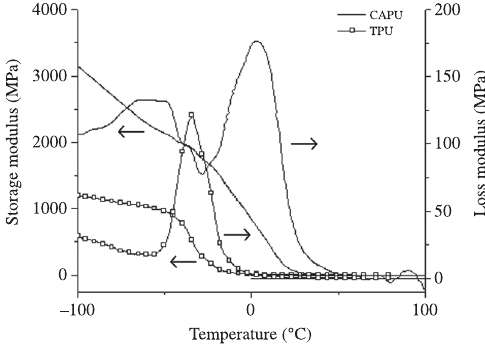
Figure 6. Storage and loss moduli of CAPU and TPU membranes.